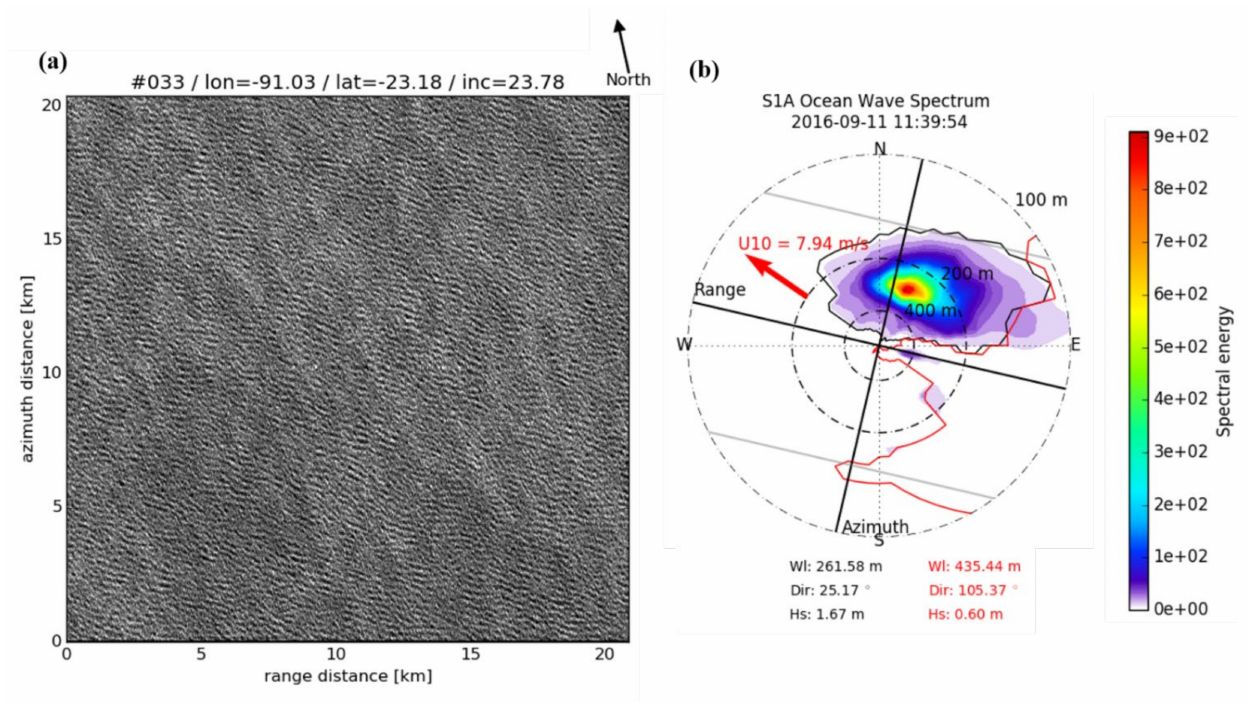
Figure 1. Flow chart of the processing of Sentinel-1A/B wave mode products from L1 to L3.